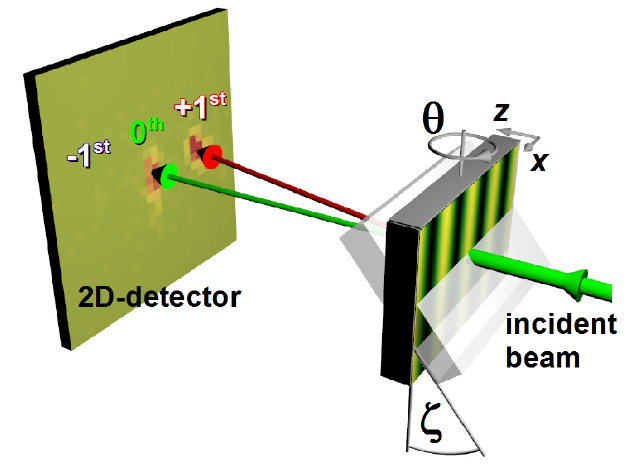
Figure 2. Experimental setup to measure the angular dependence of diffraction (rocking curve) of holographic gratings with neutrons. Upstream, the incident neutron beam is reflected by a supermirror and collimated by a Cd-slit system (both not shown). The sample size typically ranges between 0.8 and 12 cm 2